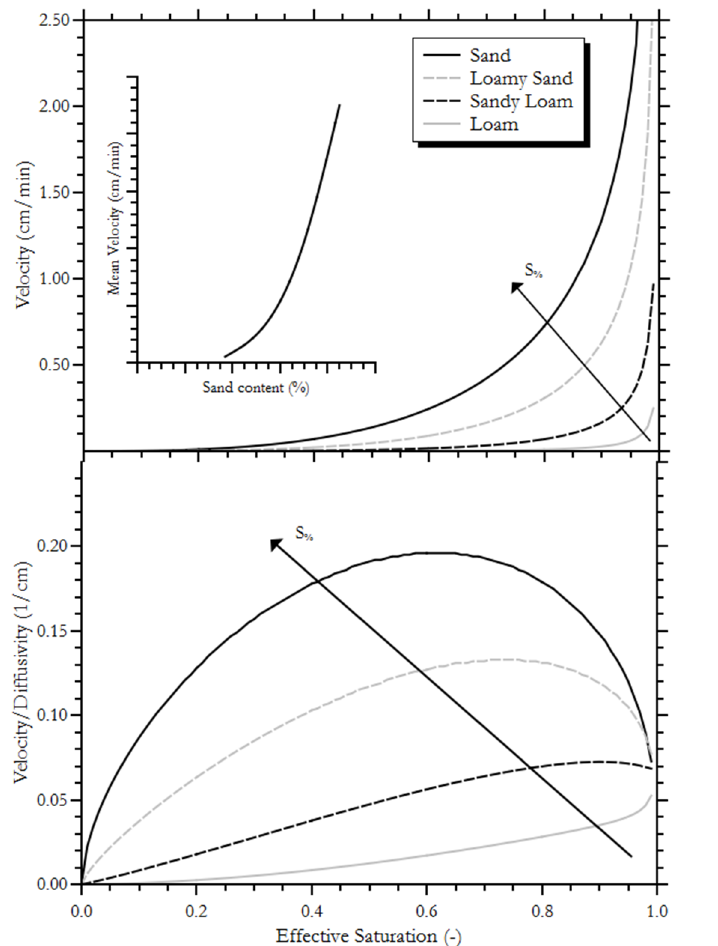
Figure 3. Water velocity and ratio velocity/diffusivity for four selected typical